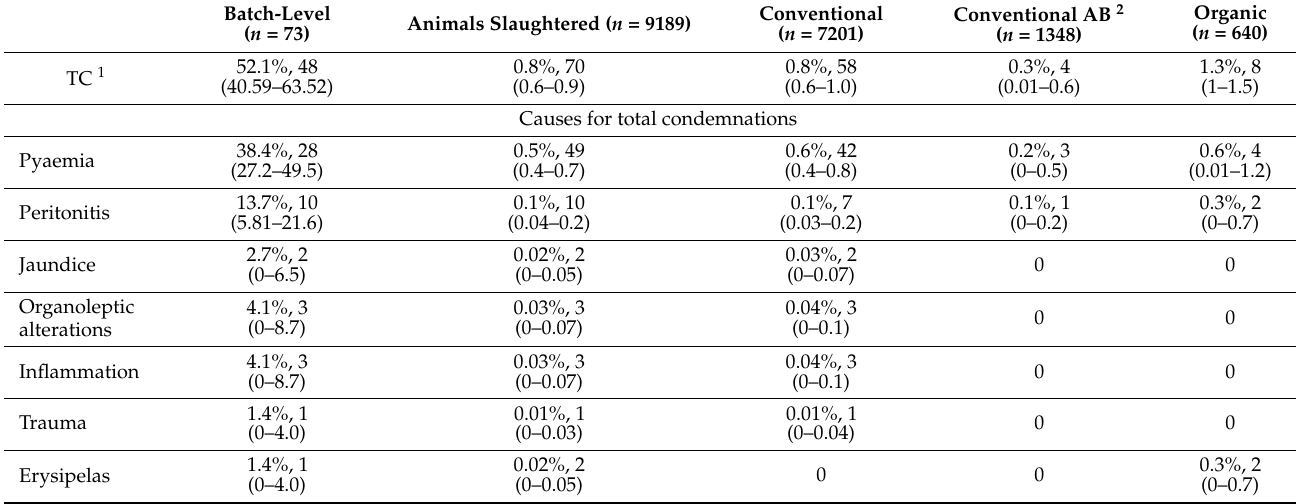
Table 2. Batch-level (% of batches with at least one condemnation/no. of examined batches) and all population-level (% of pigs/no. of examined pigs) prevalence of total condemnations (and respective cause) and its distribution over the various production types. Unless otherwise specified, 95% confidence intervals (CI) of the prevalence are reported within